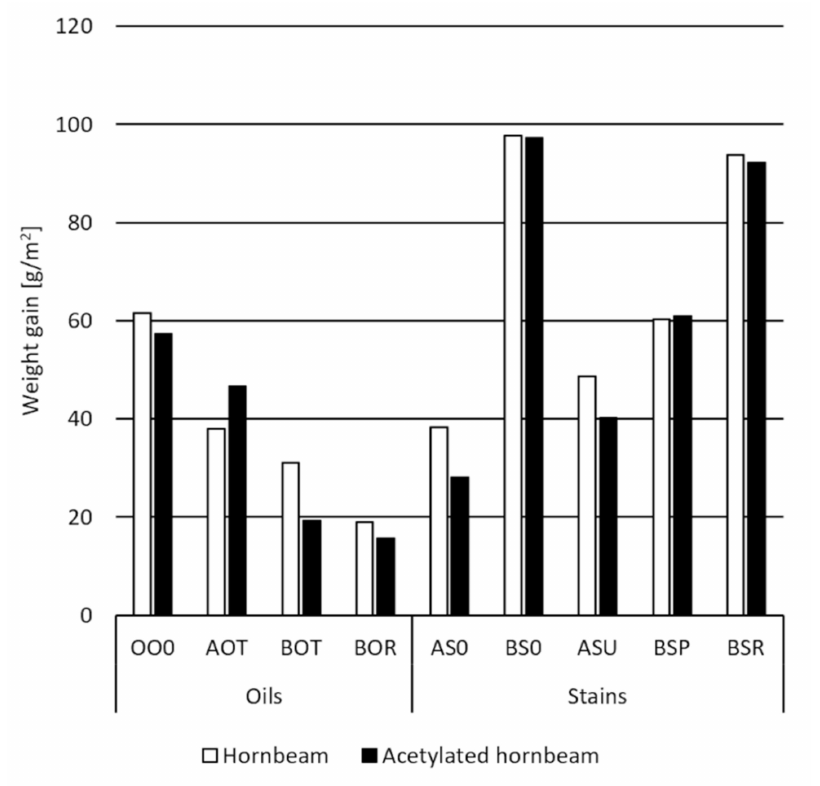
Figure 2. Weight gain of natural and acetylated hornbeam after coating, at 20 ◦ C temperature, 65% relative